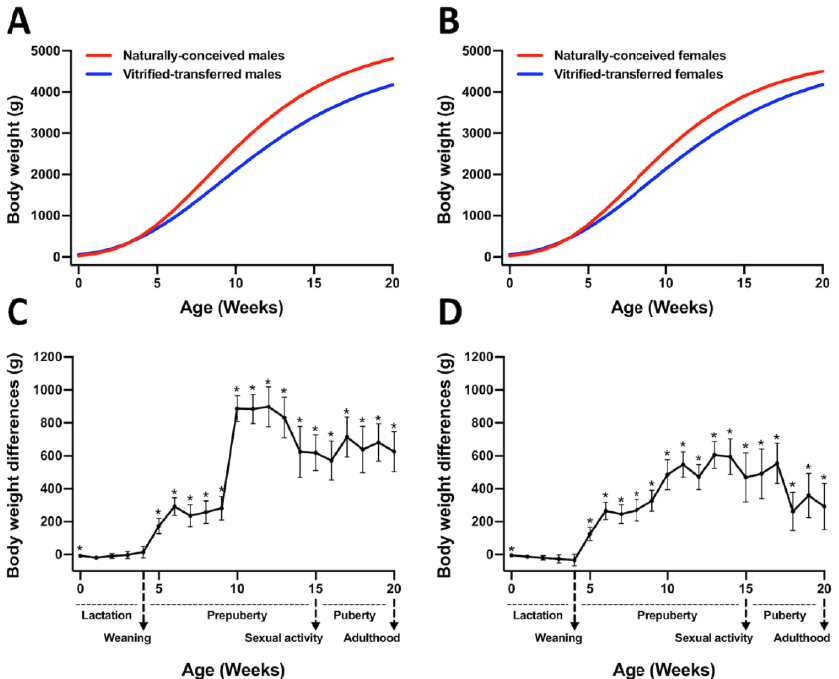
Figure 2. Growth curves and differences in body weight between animals derived after vitrified embryo transfer procedure (VT) and those naturally conceived (NC). Growth curves were fitted using the Gompertz equation for ( A ) males and ( B ) females, comparing NC and VT groups. Differences in body weight for ( C ) males and ( D ) females were computed as NC-VT. Asterisks denote significant differences.